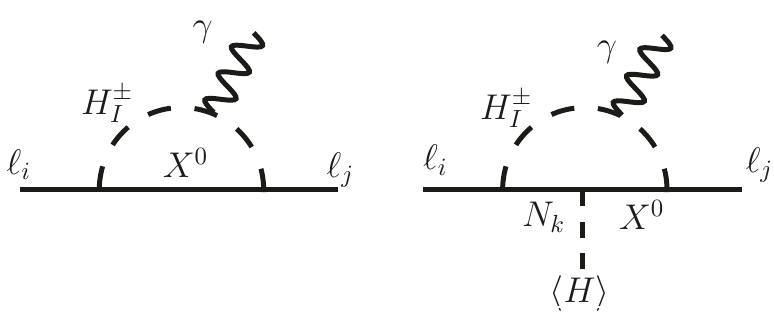
Figure 6 . Feynman diagrams for the ‘ i → ‘ j γ decays, where the decay amplitude in the left panel has an m ‘ suppression factor due to chirality-flip. The right panel exhibits the left- and i right-handed couplings at the same time, and no chiral suppression is